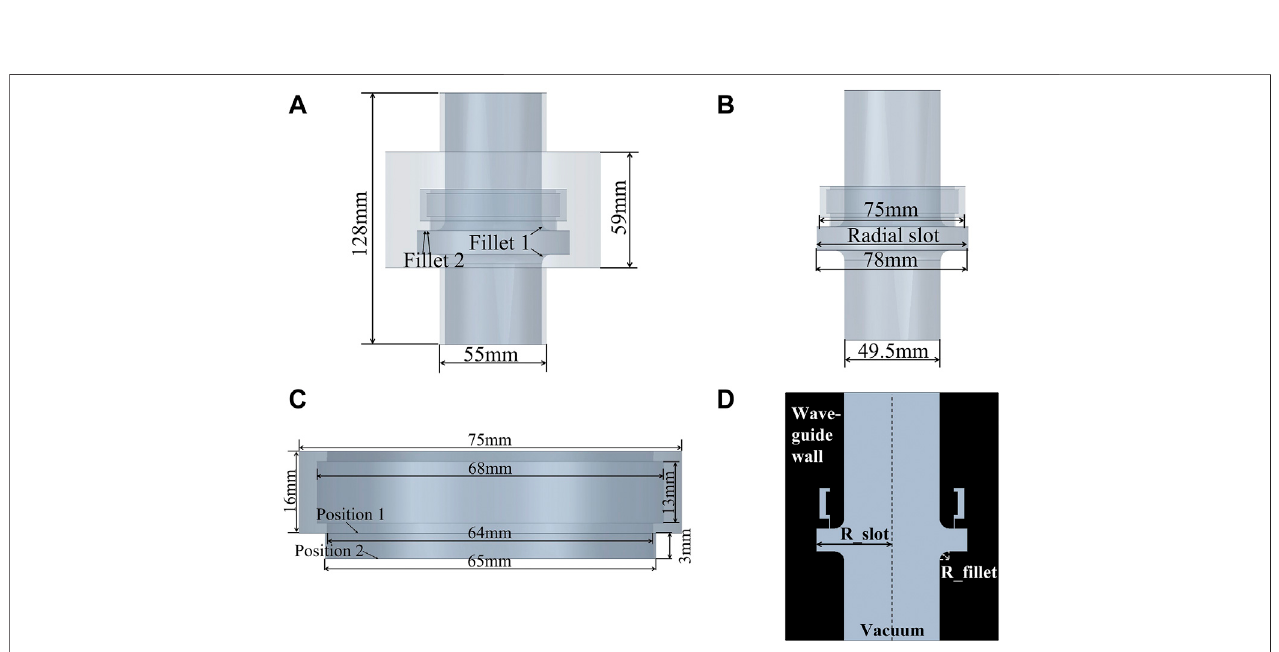
FIGURE 2 | The geometry structure of the rotary joint. (A) Front view of the external of waveguide. (B) Front view of the internal of waveguide. (C) Front view of the choke slot. (D) The sectional view of the waveguide.